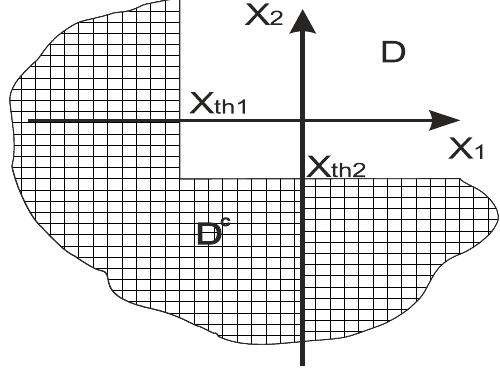
Figure 2. Shaded area of outage for a regenerative dual-hop link.